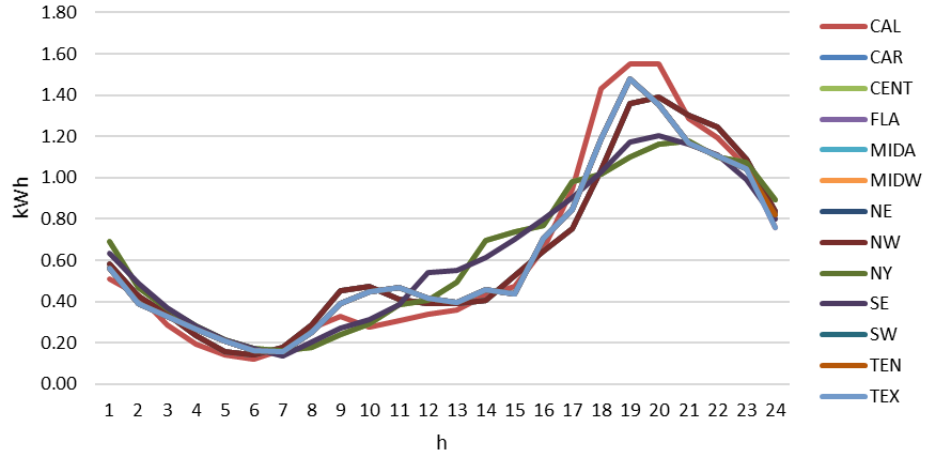
Figure 5. EV charging profiles in each